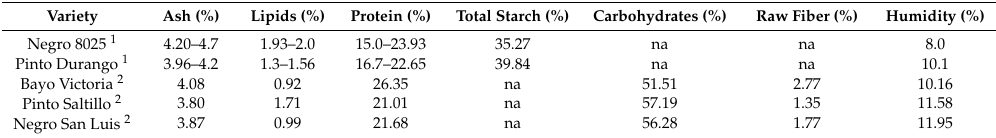
Table 1. Chemical composition of Mexican varieties of common bean raw.